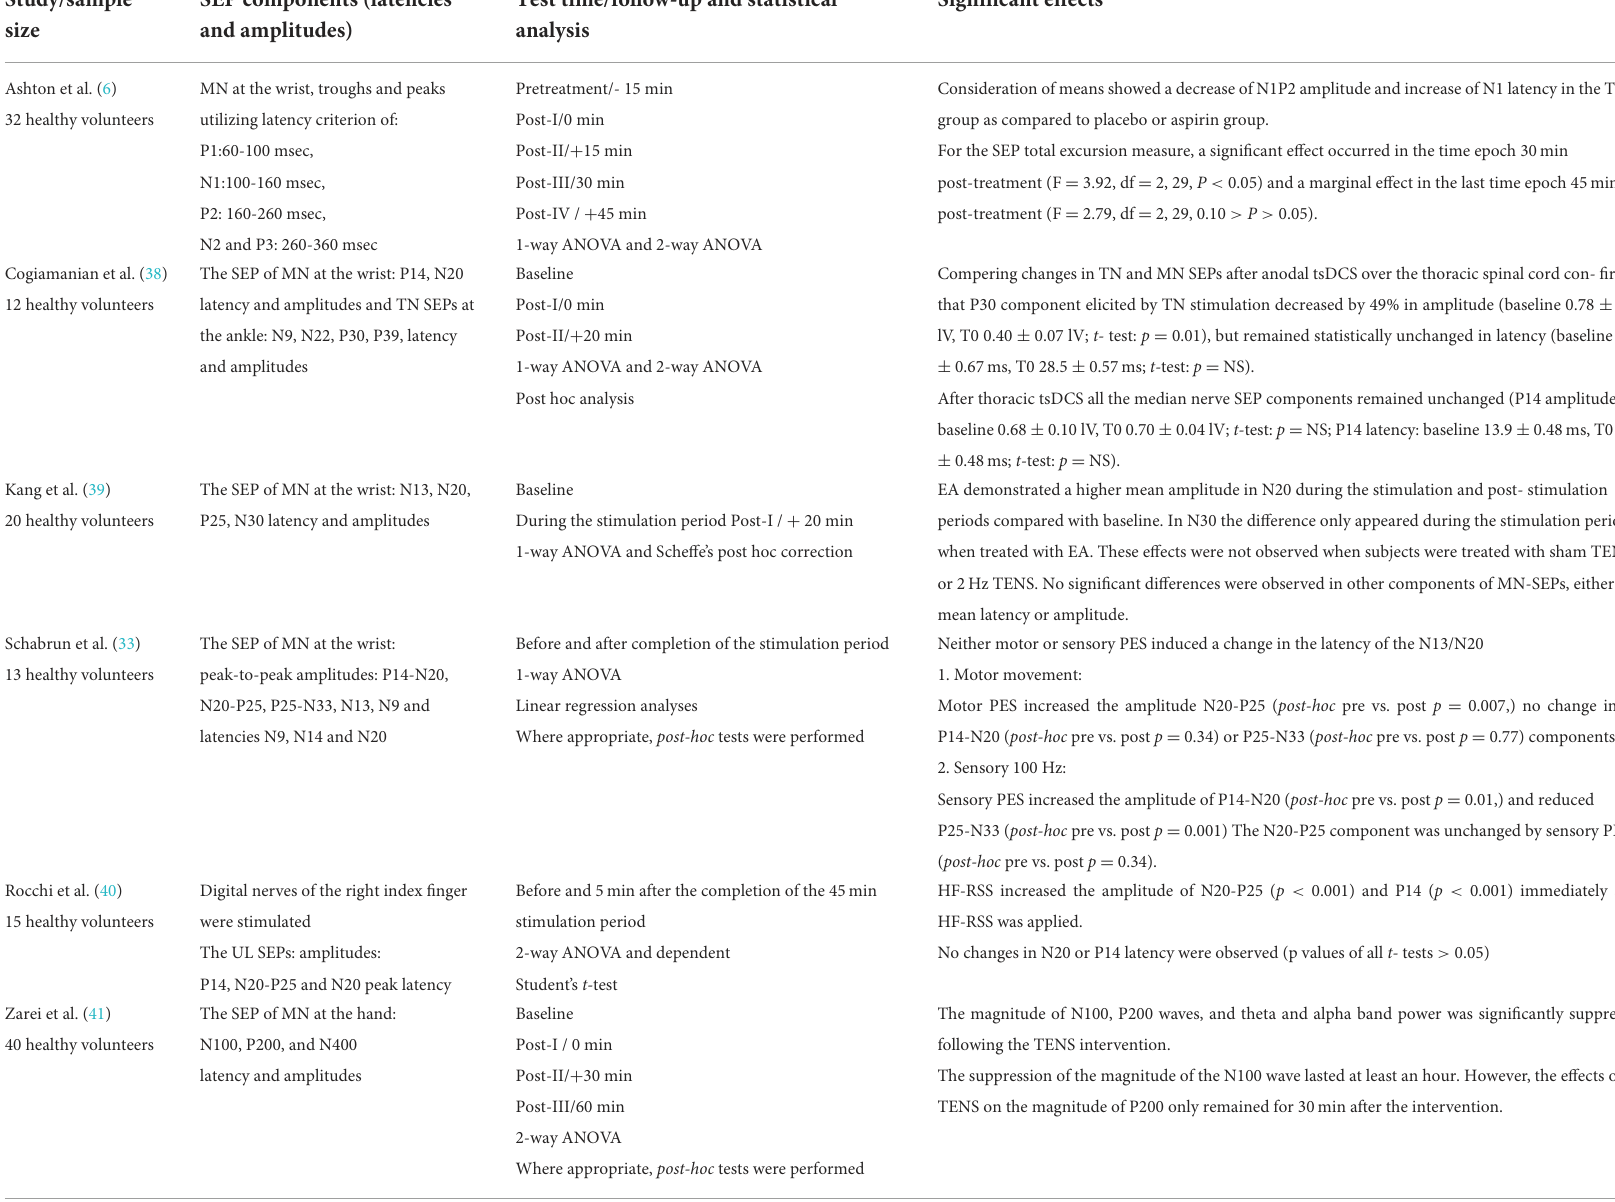
TABLE 3 Latencies and Amplitudes of SEP Components—Pre–Posttest—Studies made on healthy